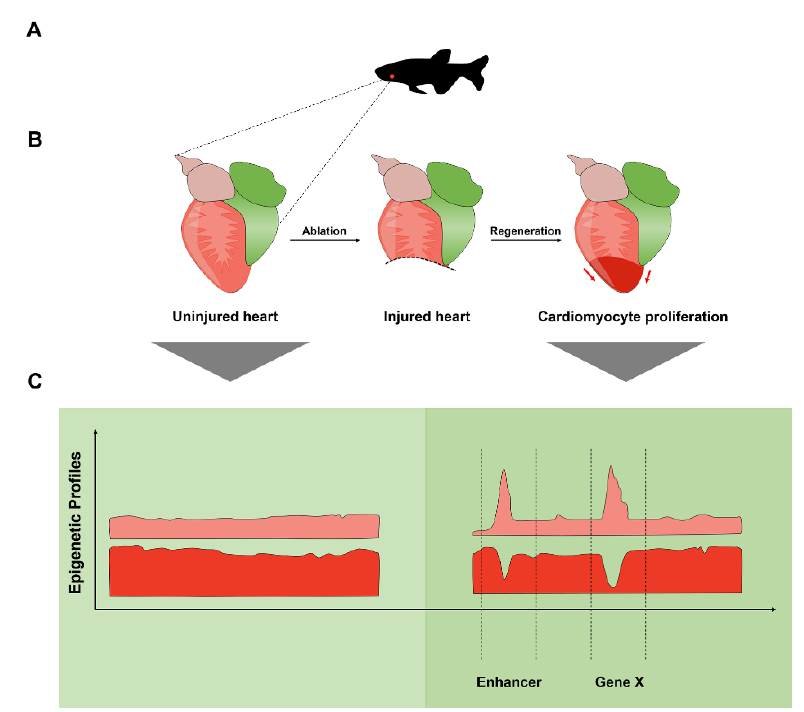
Figure 2. Zebrafish gene regulatory programs of heart regeneration. ( A , B ) Zebrafish mature heart: uninjured, injured heart after ablation, and regenerative heart by cardiomyocyte proliferation. ( C ) Enhancers that have no detectable activity in uninjured heart direct gene expression during heart regeneration.